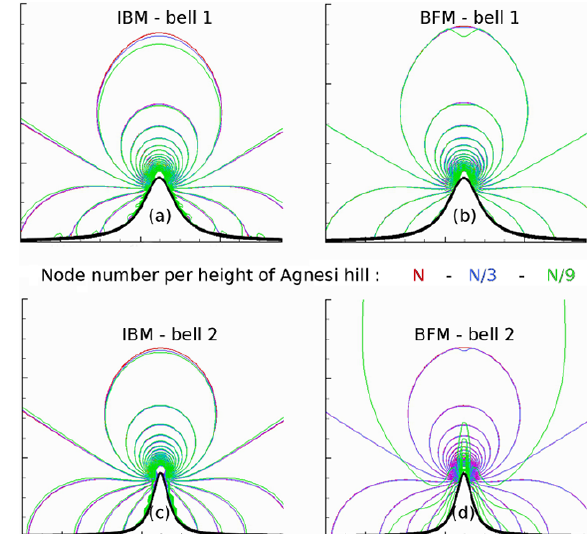
Figure A2. Potential flow function of the space resolution (color code) plotting the pressure contours around two bells ( a, b : BELL1, gentle slope; c, d : BELL2, steep slope) and obtained with IBM (a, c) and the boundary-fitted method (b, d)